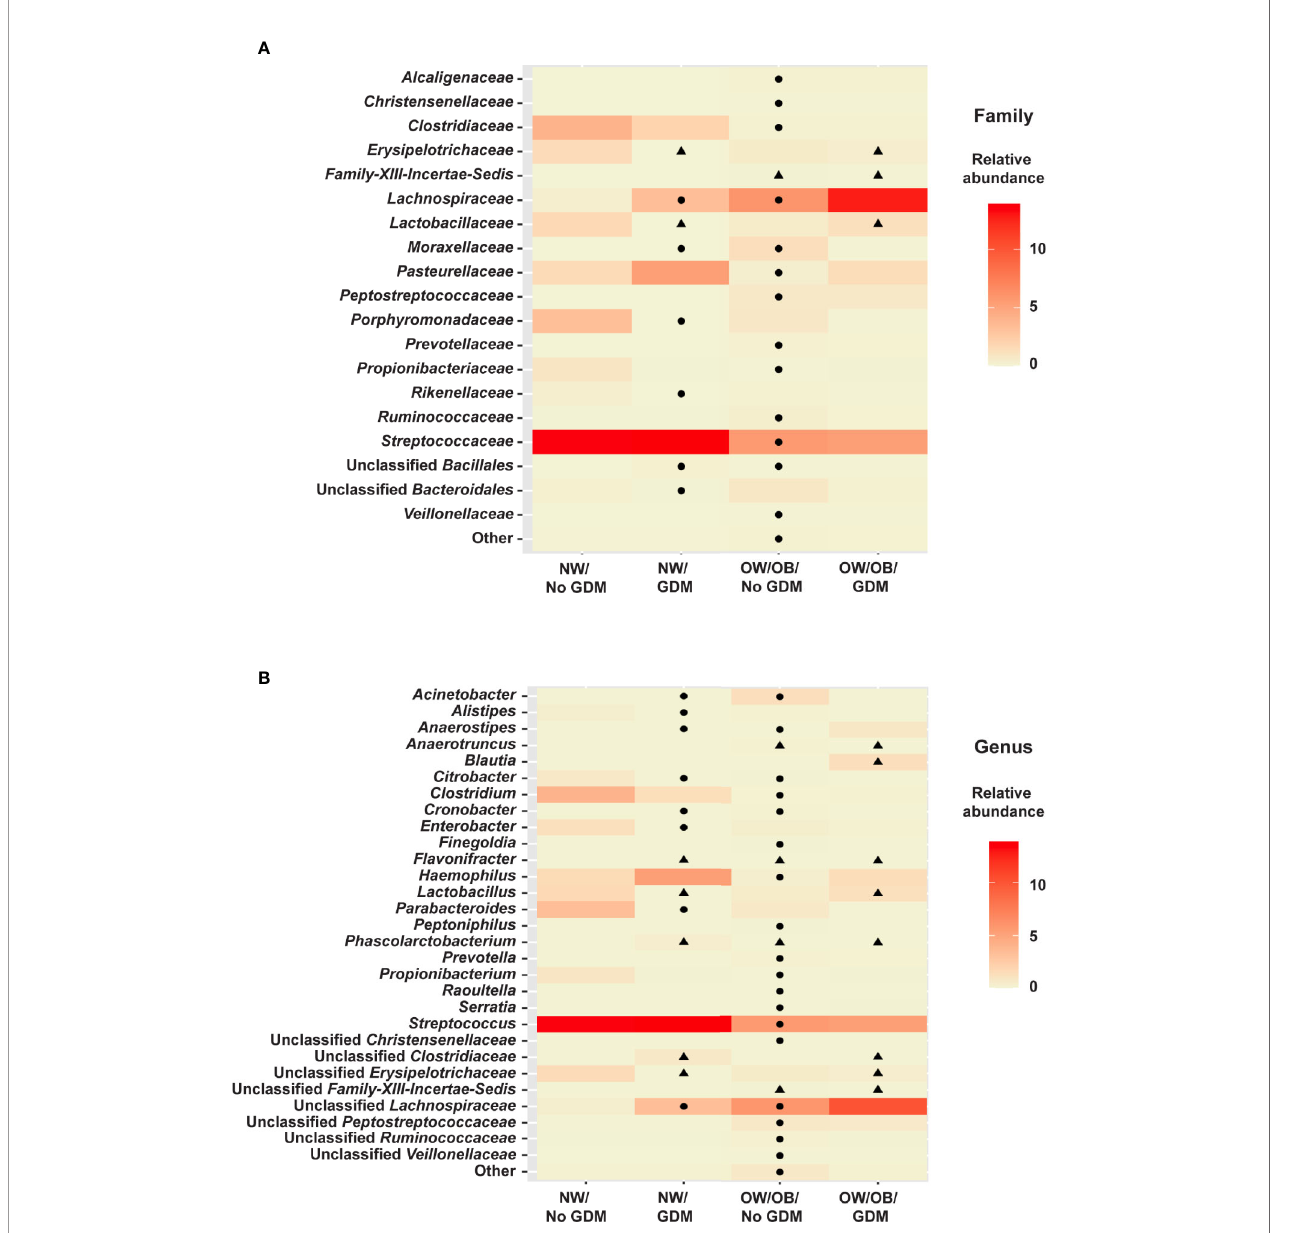
FIGURE 3 | Heat maps of signi fi cant relationships between maternal phenotype and infant gut microbiota. Average taxa relative abundances are displayed by maternal phenotype with higher averages colored a deeper red. Cells with a shape inside indicate a signi fi cantly different (FDR adjusted p value <0.05) average relative abundance from the NW/No GDM group. Triangles indicate signi fi cant differences from the interaction models and circles indicate differences from the additive models for both (A) family- and (B) genus-level